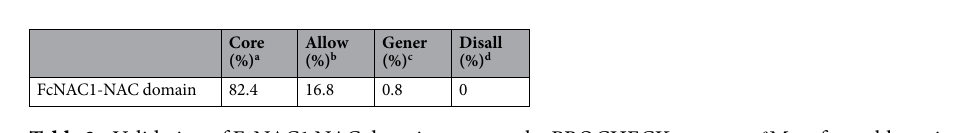
Figure 7. Homology modeling of the NAC domain present in FcNAC1 protein. ( A ) The alignment between the template (3SWM chain A) and FcNAC1 NAC domain, including structural information. Spirals and arrows at the top of the sequences represent the secondary structure of the template, while those at the botton correspond to predicted secondary structure of FcNAC1. Triangles indicate the important residues for the dimerization process and asterisk indicate conserved residues for DNA interaction. ( B ) Homology modeling of FcNAC1 NAC domain using MODELLER software. Fifty models were built and the best was subjected to energy minimization and molecular dynamics with the purpose of relaxing the structure and minimizing steric impediments. It is possible to appreciate that the cluster of β sheets is flanked on both sides by the α -helix and the α -helix 3 10 . α -helices were labeled as α , and β -sheets as β . ( C ) Homodimer structure of FcNAC1 NAC domain showing the potential residues involved in the salt/bridge interaction. ( D ) Protein-DNA positioning between the homodimer of FcNAC1 and the DNA sequence co- crystallized with the template 3SWM (5 ′ - GTCTTGCGTGTTGGAACACGCAACAG -3 ′ ). ( E ) Visualization of the homodimer structure of FcNAC1 NAC domain highlighting the positively charged residues involved in the protein-DNA interaction.